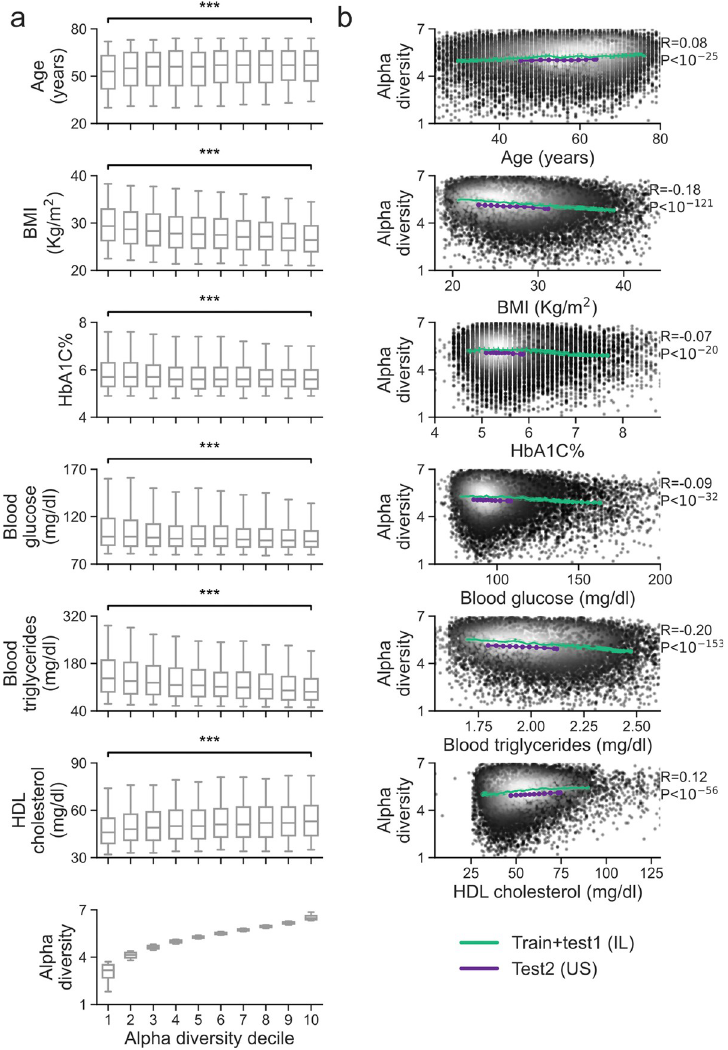
Fig 2. Species level Shannon alpha diversity significantly associates with many phenotypes. (a) A box-plot of the distribution of phenotype values, for each of 10 deciles of Shannon alpha diversity, on the IL (train + test1) population. Phenotype values in the first and last deciles of alpha diversity are compared using Mann-Whitney rank-sum test where ��� signifies P value < 10 − 16 after FDR correction. Boxes correspond to 25–75 percentile of the distribution and whiskers bound percentiles 5–95. (b) Running average of alpha-diversity (y-axis) for the combined training and test1 cohort (green curve), and for the separate test2 cohort (purple curve), ordered by the phenotype values. For the larger Israeli cohort the average is on 1000 individuals with shift of 100 individuals; for the smaller U.S. cohort the group size and shift were chosen to obtain 10 points and the shift was 10% of the group size. The Spearman correlation and P- value shown are of the Israeli cohort, and are calculated on individual level data. Individual level data points are presented with grayscale colors. Data points with light colors have higher frequency.